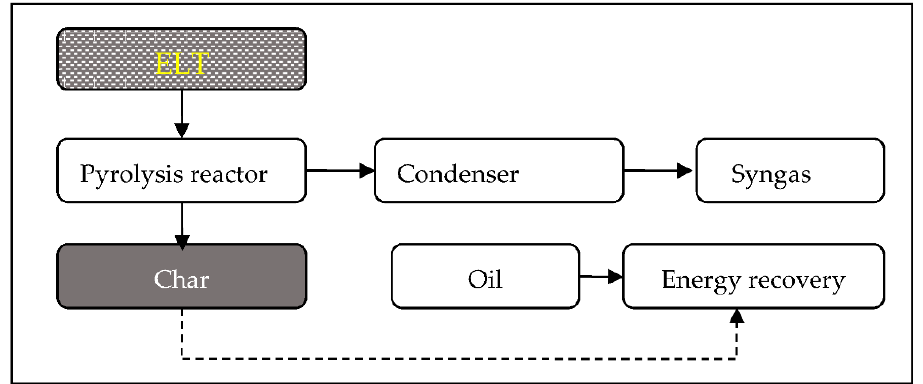
Figure 2. The pyrolysis process obtains scrap tires as energy storage.